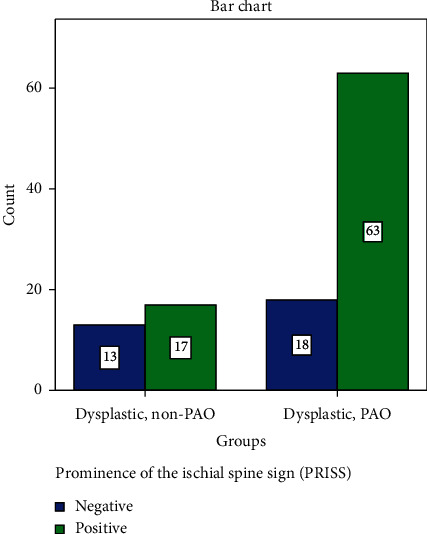
The crossover sign in all dysplastic hips (PAO vs. non-PAO); χ2 = .027, P=0.488.